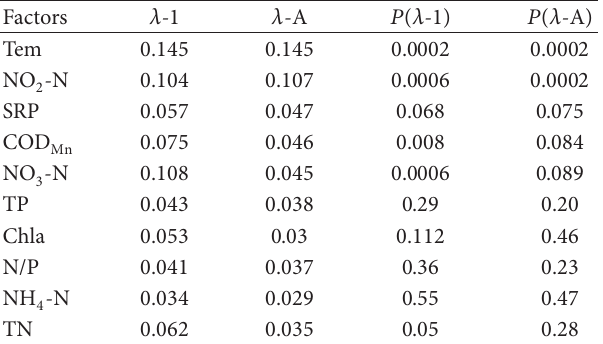
(Figure 5(b), bottom-left quadrant). H. mira , E. senta, and Co. hippocrepis preferred high NO 2 -N and low COD Mn and were abundant in warm seasons of the last two years. K. quadrata , F. passa, and B. calyciflorus populations grew in cold season. As. priodonta and other species preferred warm temperature and occurred in every year of the